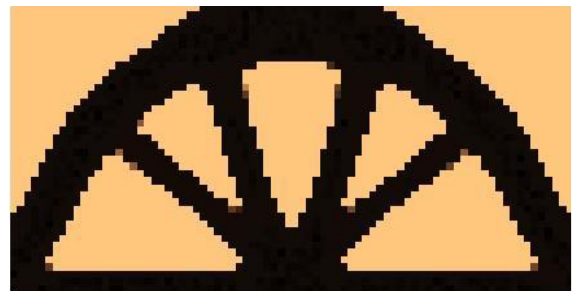
Figure 7. The final topology.